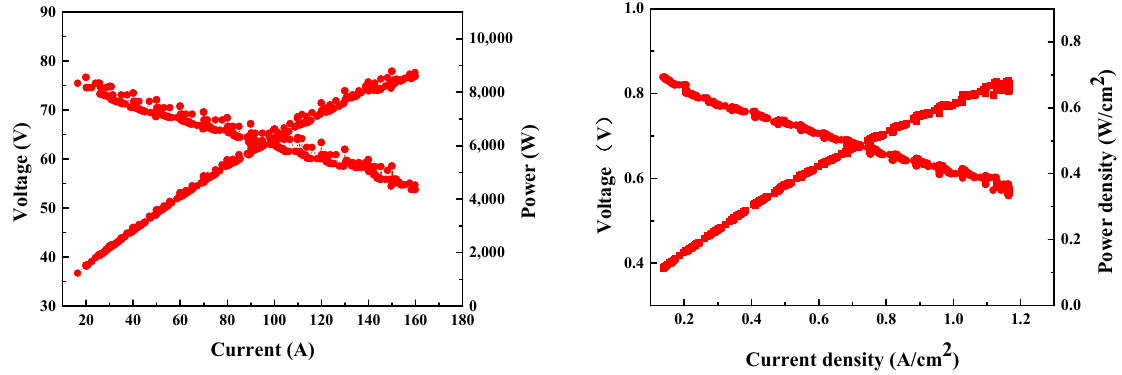
Figure 4. Performance of PEMFC in the fuel cell system (test condition: H 2 /air stoichiometric ratio: 1.2/2.68, H 2 /air back-pressure: 35/8 kPa).